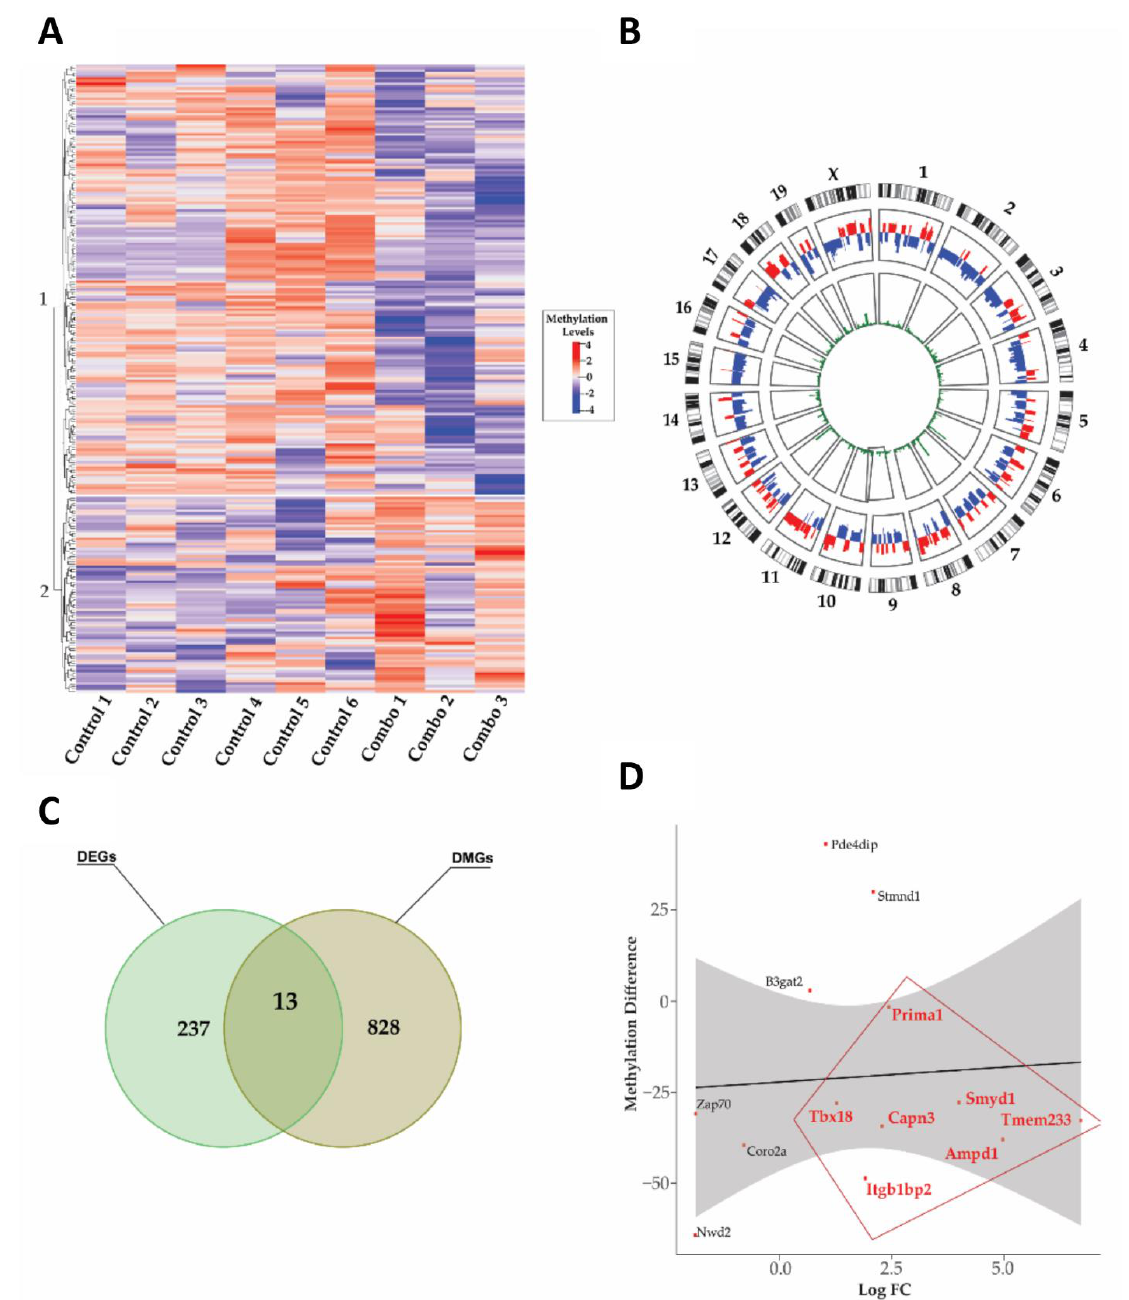
Figure 7. Methylomic-level changes in the combination treatment group. ( A ) Heatmap representing DMGs in control and combination (BSp + GTPs) treatment groups, wherein rows correspond to DMGs, and columns represent biological replicates in control (N Control = 6) and the combination (N Combination = 3) treatment groups. Blue color represents lower methylation level and red indicates higher methylation level. ( B ) Circos plot showing the overall distribution of DMGs across chromosomes. Y chromosomes were excluded as only female mice were used in this study. ( C ) Integrated analysis identified 13 target genes showing both differentially methylated (DM) and differentially expressed (DE) in the combination treatment group. The green circle represents DEGs; the yellow color represents DMGs. ( D ) Scatter plot showed in 13 target genes, 7 genes ( Ampd1 , Capn3 , Itgb1bp2 , Prima1 , Tbx18 and Tmem233 , dots in red color) were upregulated and hypomethylated. The y -axis represents methylation difference, and the x -axis represents log 2 FC.